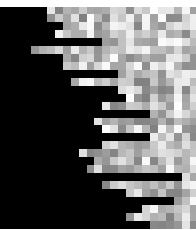
Figure 12. A 28 × 28 pixel example of a crop pattern used in transfer training the CNN in Table